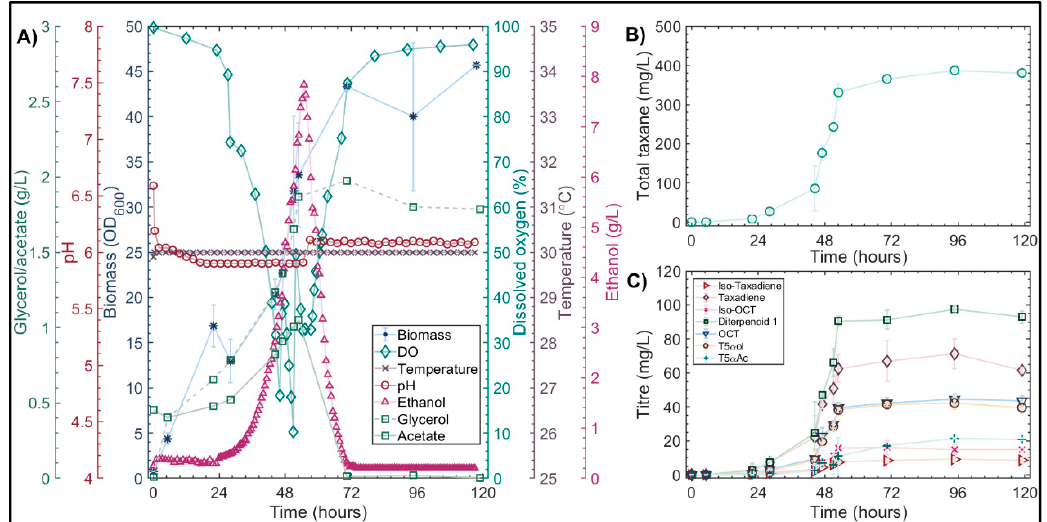
Figure 7. Optimized complex media in 1L BIOSTAT Bioreactor at 30 ◦ C. ( A ) Biomass ( ∗ ) , ethanol ( ∆ ), DO ( (cid:5) ), temperature ( × ), pH ( ) , acetate (– (cid:3) ) and glycerol (– (cid:3) ) production. ( B ) Total taxane production. ( C ) Accumulation of key Taxol intermediates. Biomass and taxane values are the mean ± standard deviation for two bioreactor cultivations. Other parameter values are from one replicate